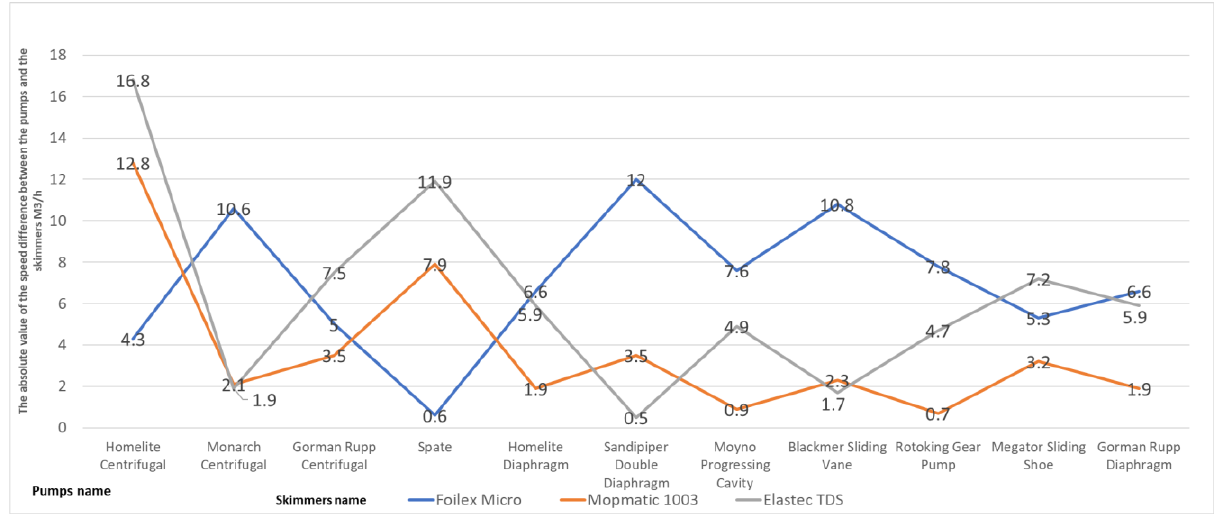
Figure 9. The speed difference of oil collection between the pumps and the skimmers: Foilex Micro, Mopmatic 1003, and Elastec TDS.